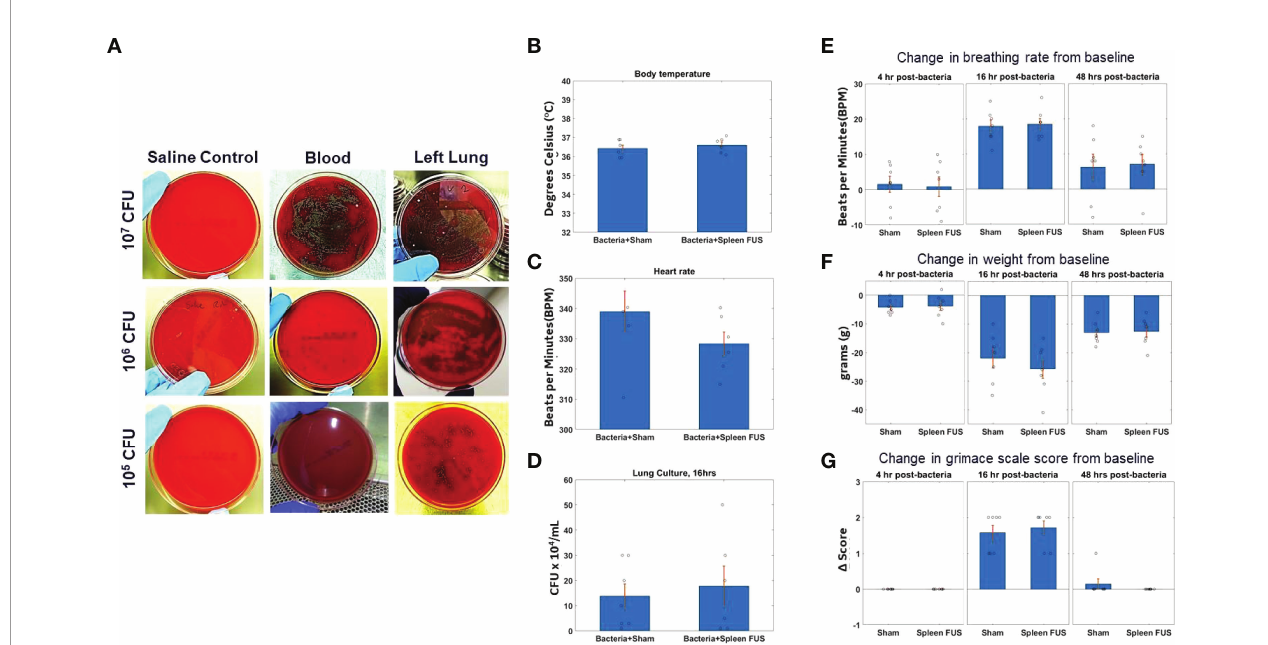
FIGURE 1 | S. Pneumonia dose titration and change in physiological markers. (A) Blood and lung cultures in sheep blood agar plates at 16 hours timepoint after bacterial inoculation of different doses from 10^5 to 10^7 CFU. The left column shows lung culture plates after saline instillation. The middle and right columns shows blood and lung culture plates after bacterial inoculation as different doses. ( B – D ; n=6) Body temperature, heart rate and lung culture after 16 hours of bacterial inoculation in sham and splenic ultrasound groups. ( E, F ; n=7) Change in breathing rate and body weight from the baseline (i.e., before bacterial inoculation) at 4 hours, 16 hours, and 48 hours post bacterial infection/instillation. (G) Grimace score for pain assessment at 4 hours, 16 hours, and 48 hours post bacterial infection/instillation. Grimace score re fl ects 0=normal, 1=moderate, and